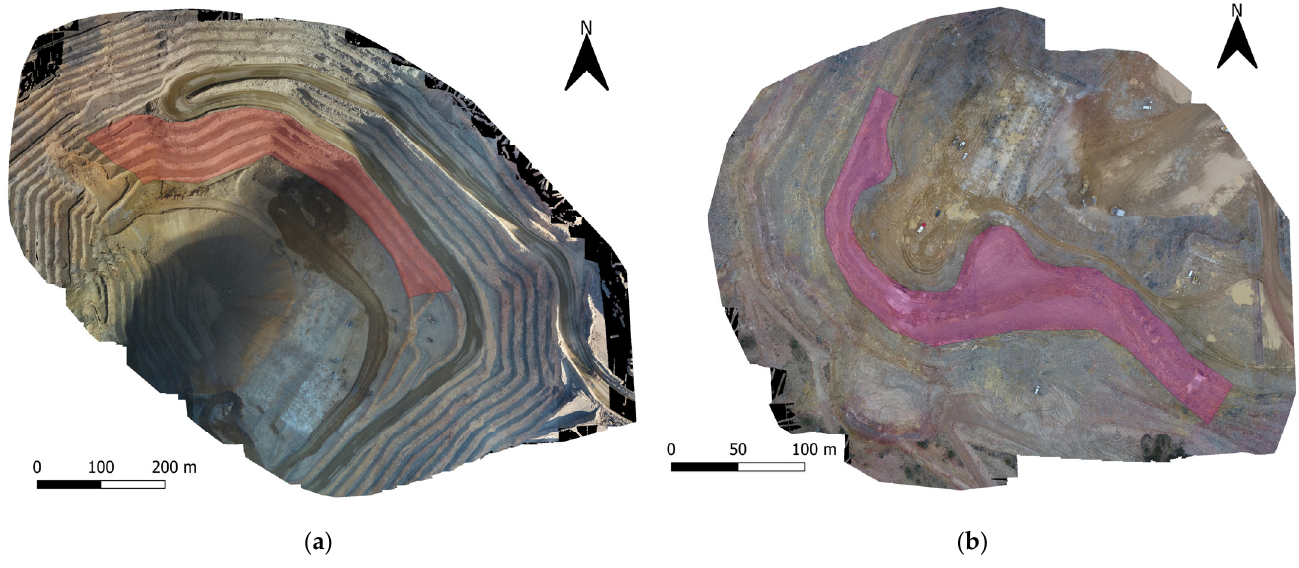
Figure 2. ( a ) The northern area of Kinross Gold Bald Mountain Mine’s Top Pit. ( b ) The southeastern area of McEwen Mining Gold Bar Mine’s Pick Pit. The highlighted regions roughly indicate the pit wall sections that were covered. Table 1. Flight plan details for the detailed pit wall mapping of Top Pit and Pick